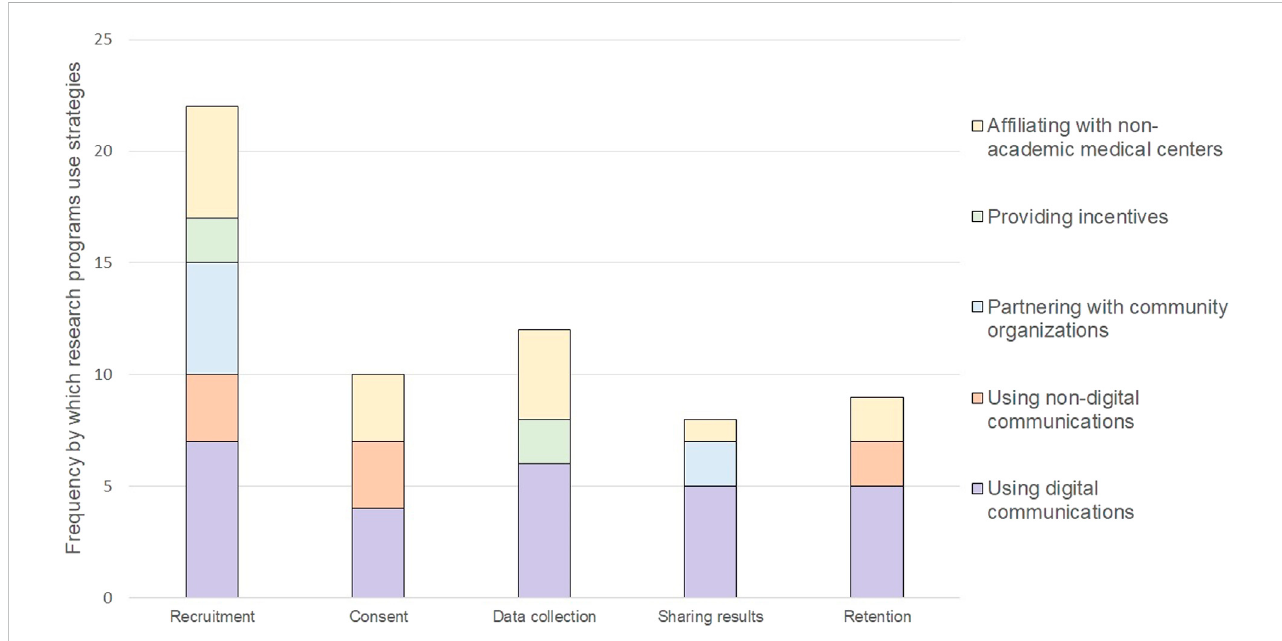
FIGURE 1 Frequency of strategies used to engage participants throughout conduct of